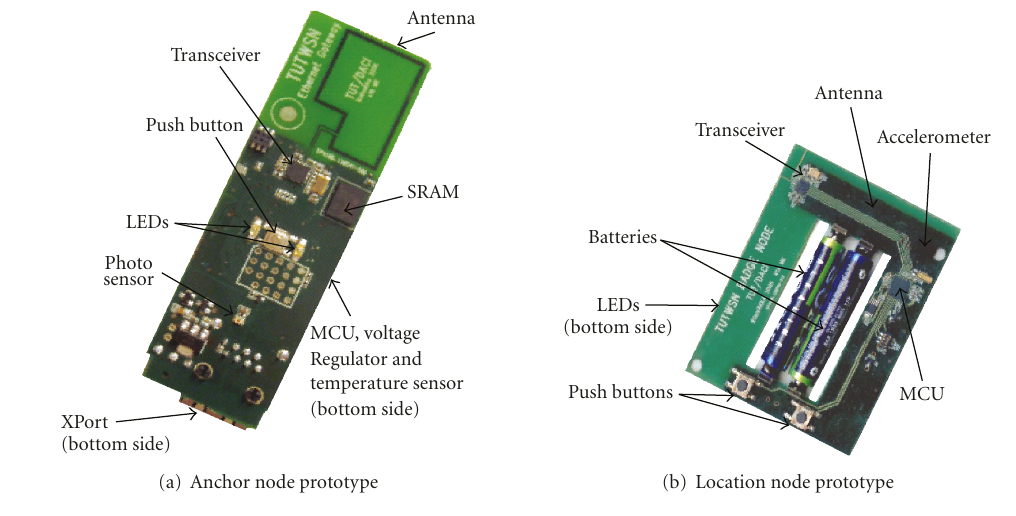
Figure 18: Anchor node and location node prototype platforms.